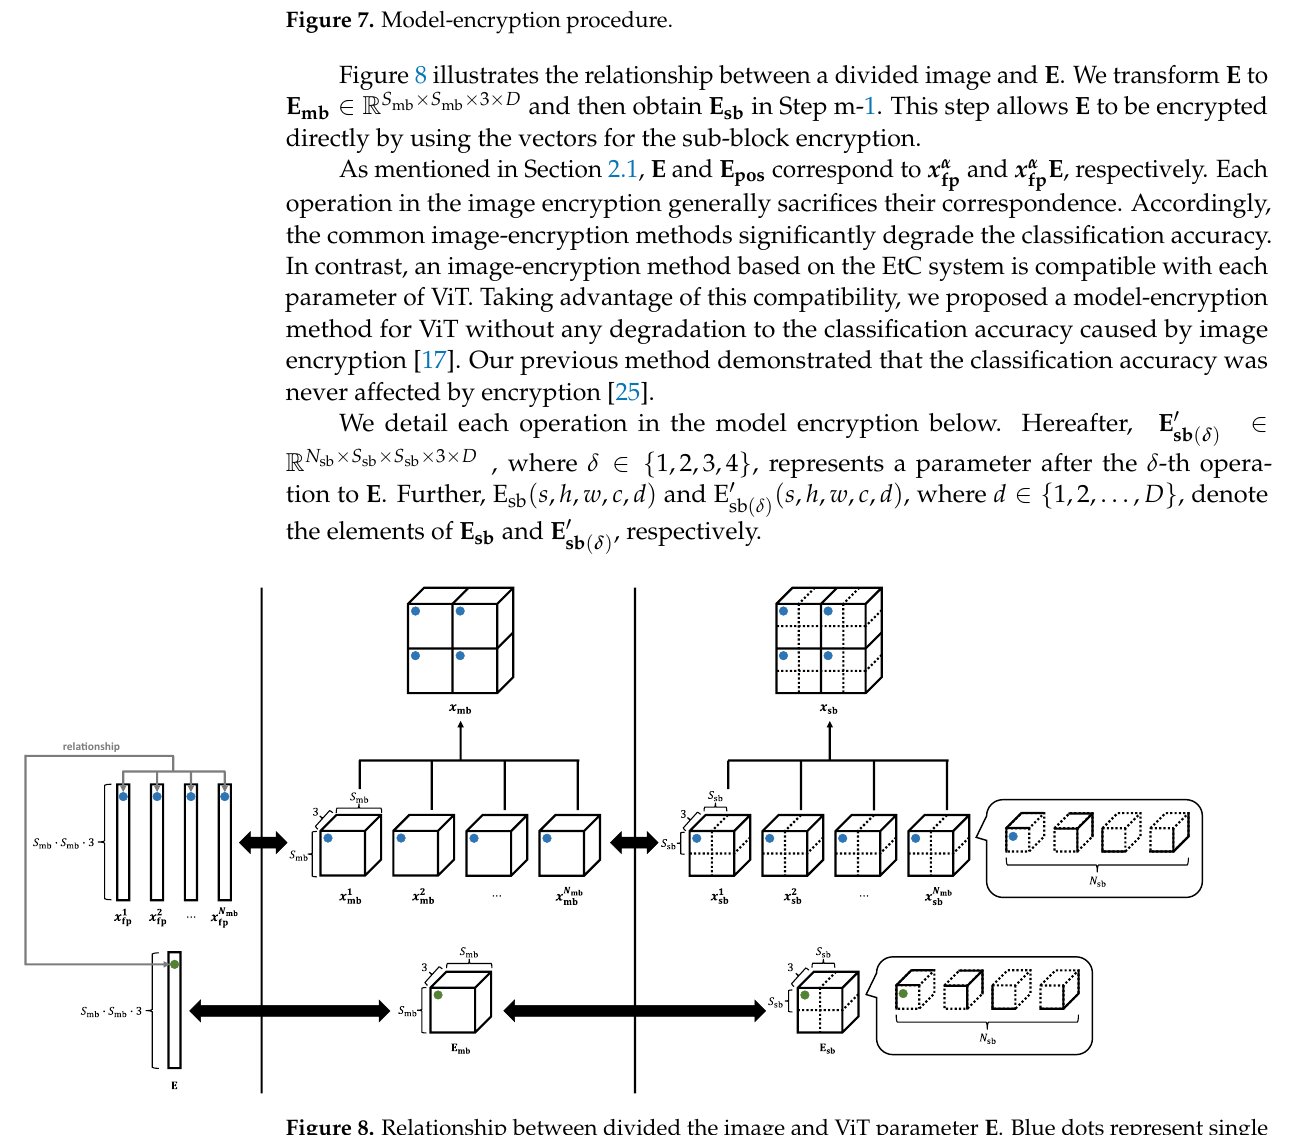
Figure 8. Relationship between divided the image and ViT parameter E . Blue dots represent single pixels in the segmented image, and green dots represent single rows in E corresponding to blue